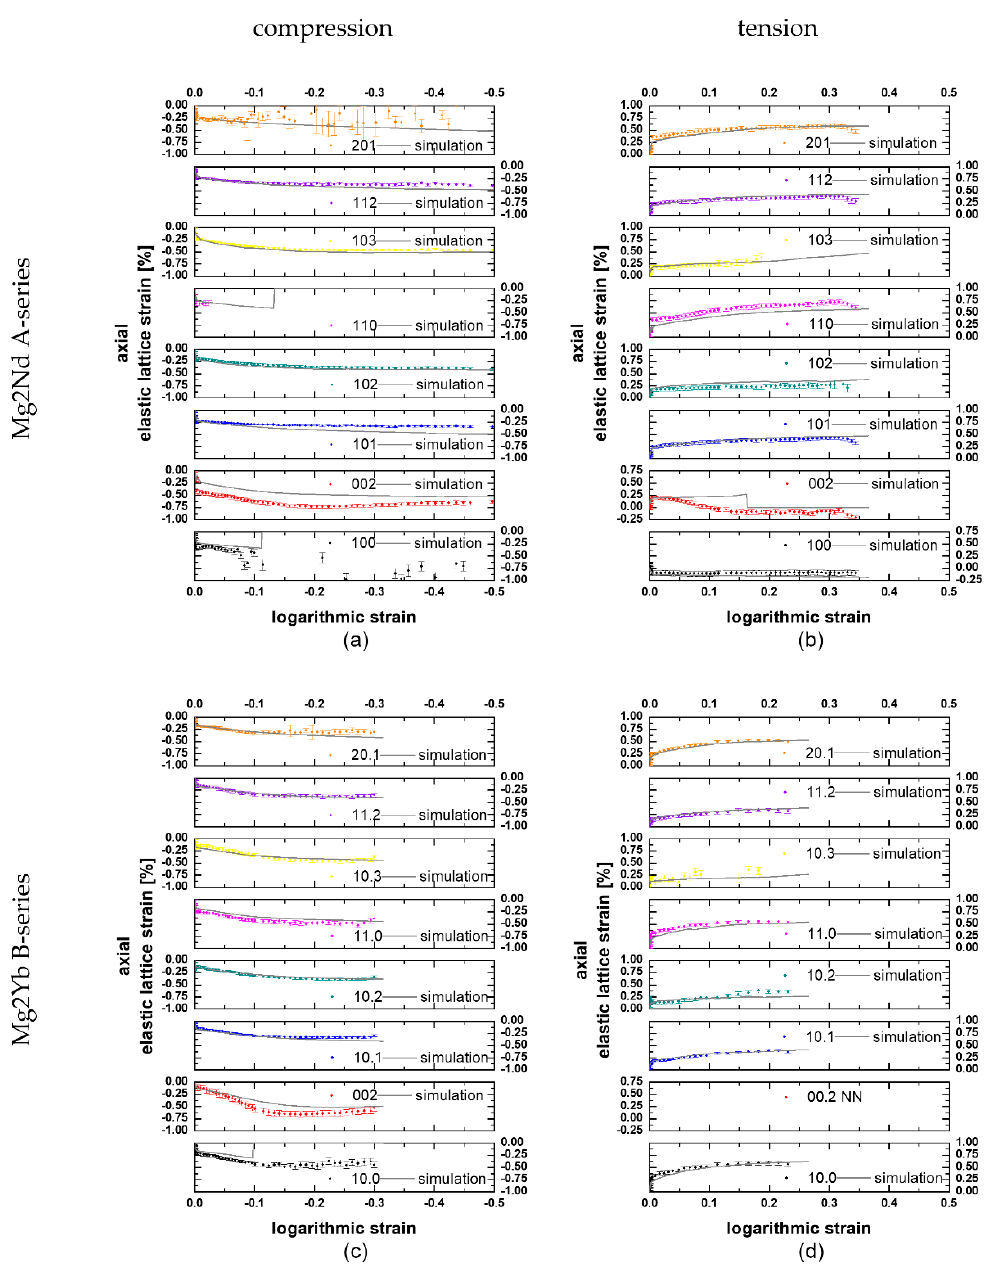
Figure 5. Comparison of the experimentally measured and simulated axial elastic lattice strains of the Mg2Nd A-series during ( a ) compression and ( b ) tensile tests and the Mg2Yb B-series during ( c ) compression and ( d ) tensile tests.